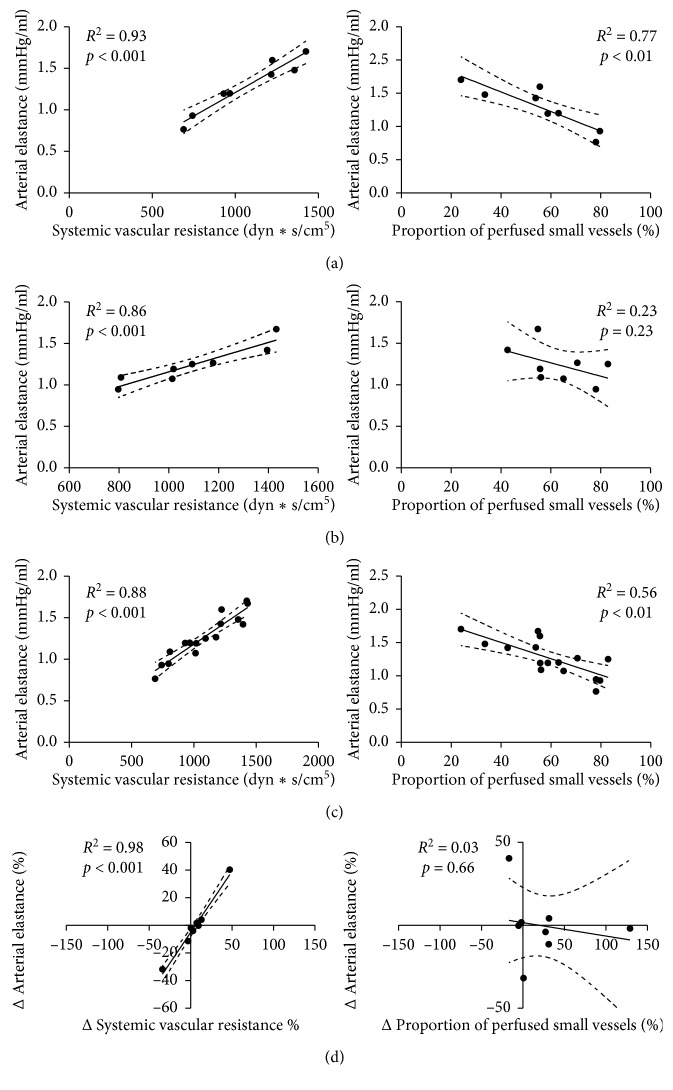
Correlation between arterial elastance and systemic vascular resistance (left column) and between arterial elastance and proportion of perfused small vessels (right column) in nonresponders. (a) Baseline (T0); (b) after fluid challenge (T1); (c) all data (baseline plus after fluid challenge); (d) percentage of change between baseline and after fluid challenge.